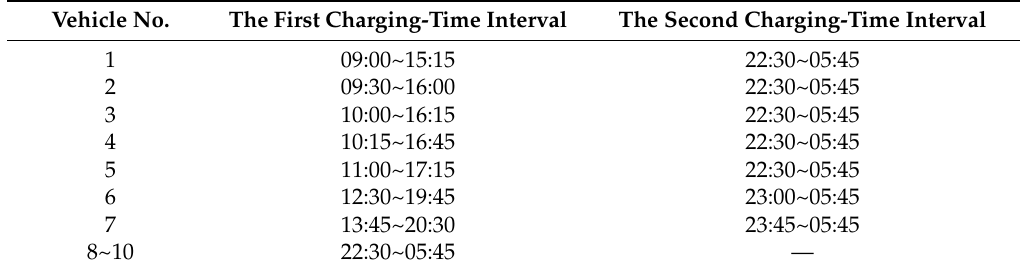
Table 2. EB charging time intervals.